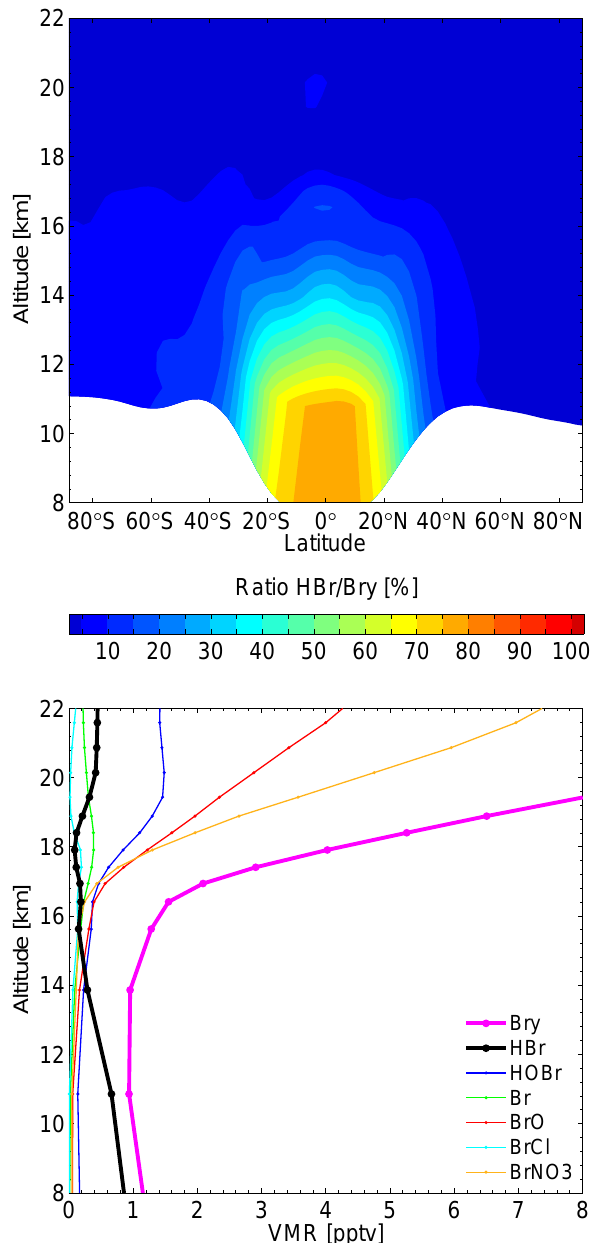
Fig. 4. Average Br y partitioning for 2006 derived from the full chemistry run. Top panel: Ratio of the soluble species HBr to Br y . Bottom panel: Profiles of Br y constituents in the tropical